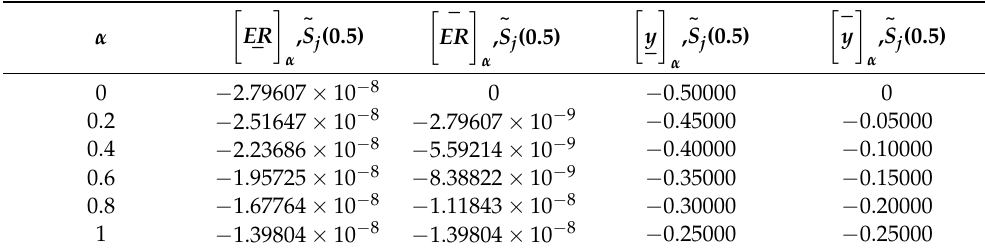
Table 2. The approximate solutions and errors for Equation (31) using the fifth-order FF-OHAM at x = 0.5 for all α ∈ [ 0,1 ] .